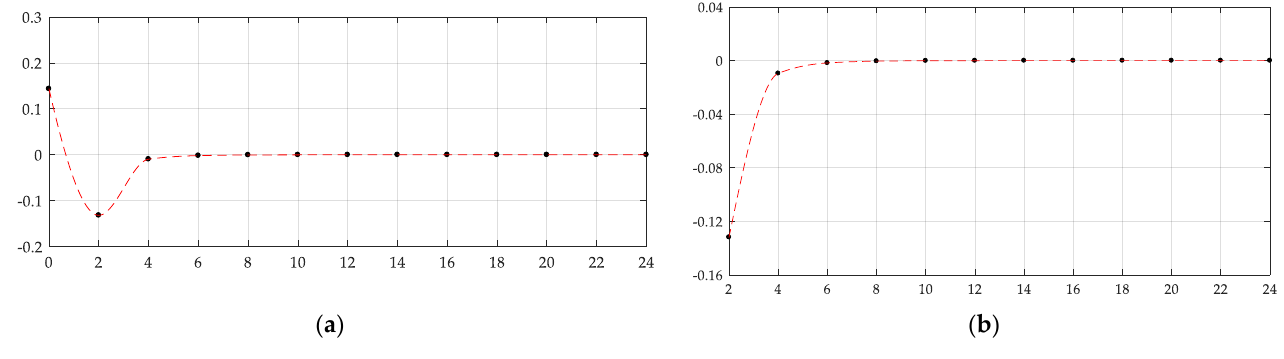
Figure 8. The values of